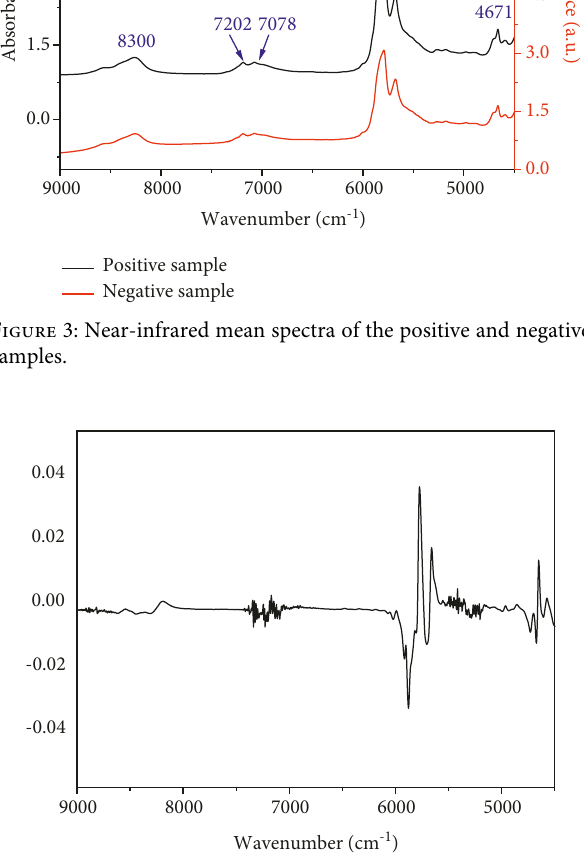
Figure 4: The first derivative near-infrared spectrum of the positive sample.